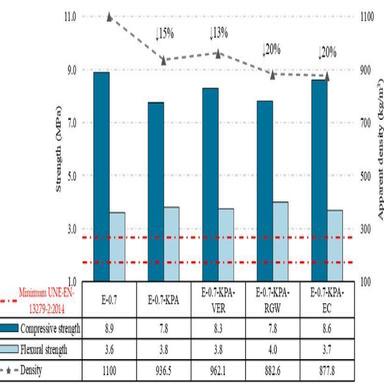
Mechanical properties and density results comparison.